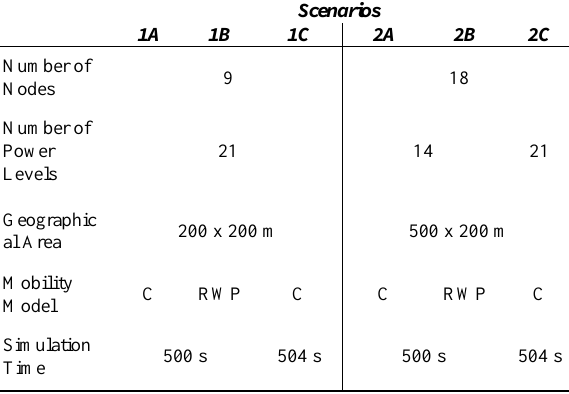
Table 1. Summary of the Scenarios ( C refers to a C onstant mobility model).